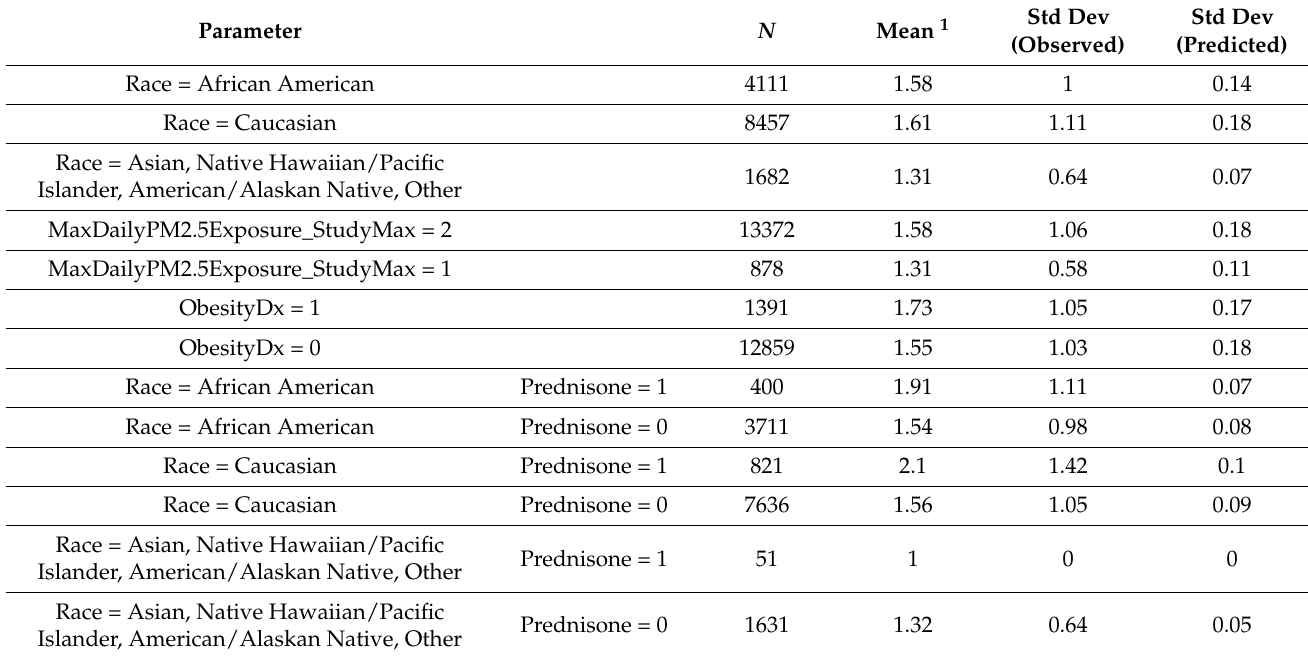
Table 4. Observed versus predicted mean annual ED or inpatient visits for respiratory